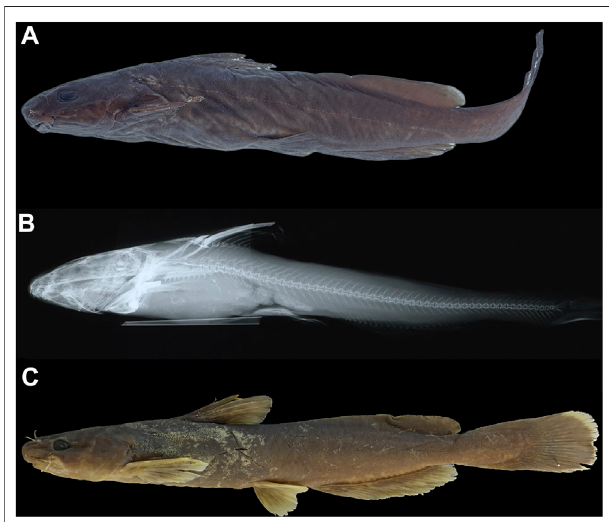
FIGURE 8 | Tachysurus similis : AMNH 8444, holotype, 119 mm SL; Nanping, Fujian Province, in lateral view (A) and X-ray (B) of body. IHB201809021142, topotype, mm SL, 152 mm SL Nanping, Fujian province (C) .